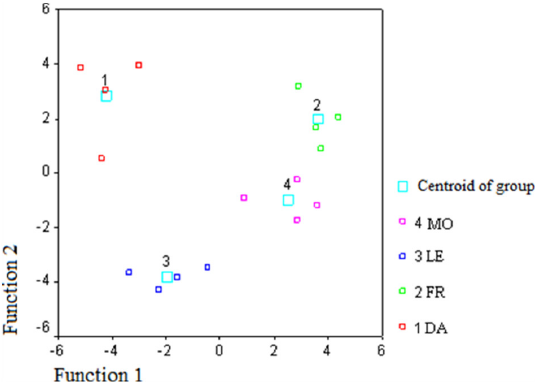
Figure 2. Discriminant function plot of the first two functions obtained using total and intrapositional FA percent composition of monovarietal EVOO samples (DA, Dolce Agogia; FR, Frantoio; LE, Leccino; MO, Moraiolo).